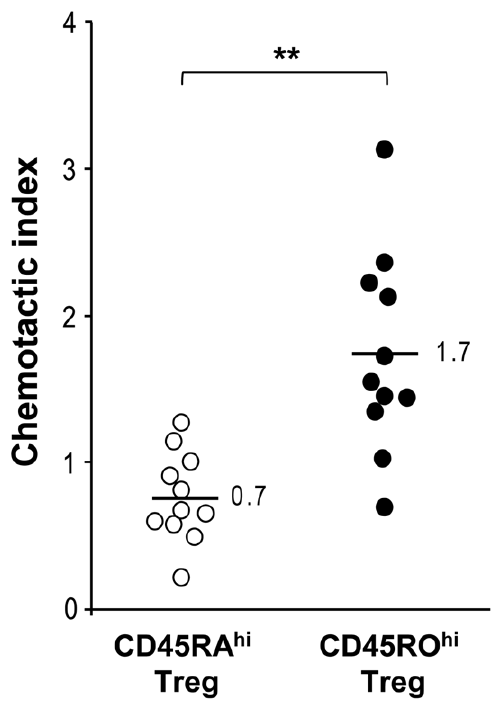
Figure 4. Chemotactic activities for CD45RA hi Treg and CD45RO hi Treg subsets. Chemotactic indices (CI) of Treg from a healthy donor towards CSF supernatants of 11 MS patients as determined by transwell migration assays. Original input PBMC and migrated cells were stained for CD4, CD25, FOXP3, CD95, CD45RO, and CD45RA, and CIs were calculated by dividing percentages of Treg subsets in CD4 + T-cells of migrated cells by percentages of Treg in CD4 + T-cells in original input PBMCs. Symbols indicate CIs of individual patients. Means are indicated, ** indicates p , 0.001.